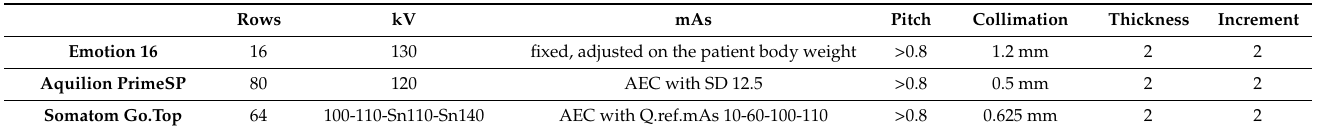
Table 1. Technical parameters of the CT protocols. The Table 1 summarizes and compares the technical parameters set on the three CT scans employed in this study to obtain chest